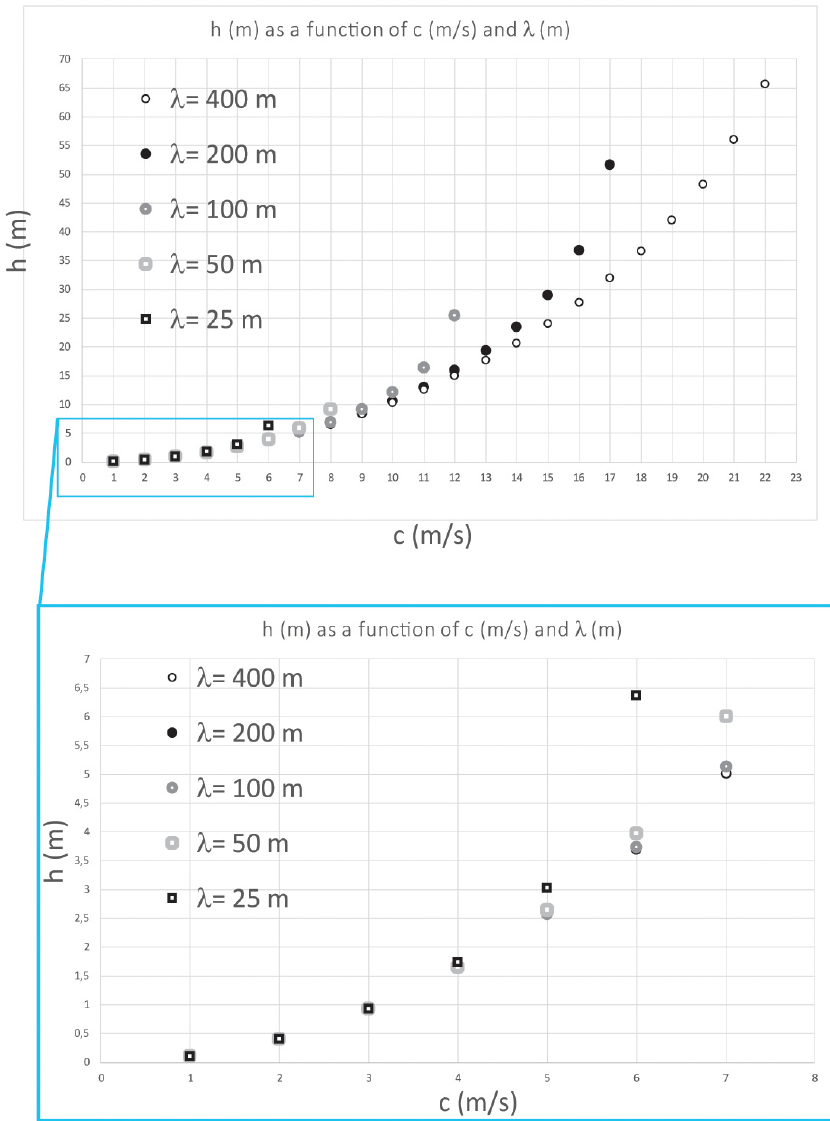
Figure 7. Example of the h dependency on c and λ for five values of λ , from Equation (1). It can be seen that the precision of the measured celerity was much more critical than the wavelength.